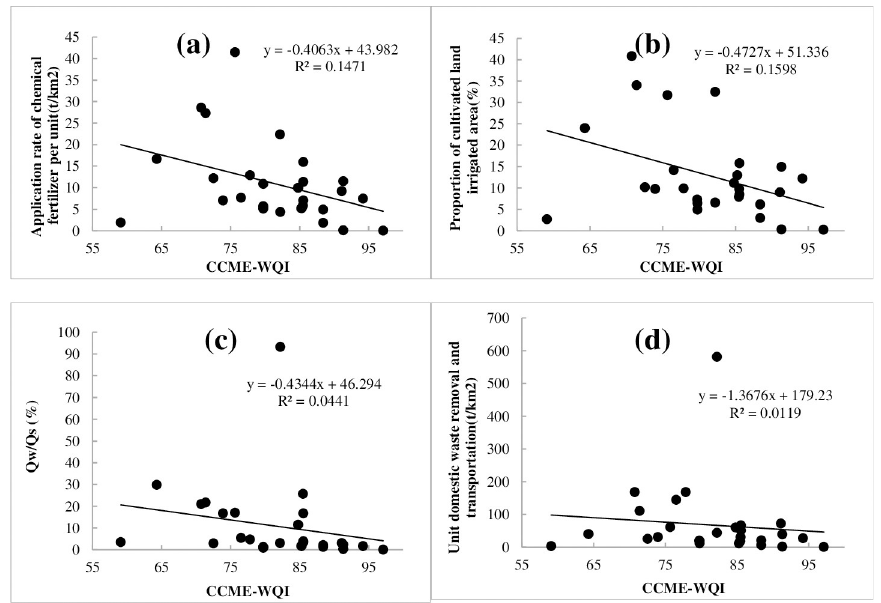
Fig 10. Correlation analysis between water quality and direct influencing factors. ((a)-application rate of chemical fertilizer per unit area (t/ha); (b)-Proportion of cultivated land irrigated area (%); (c)-total wastewater discharge/Total surface water resources (%); (d)-unit domestic waste removal and transportation (t/ha)).